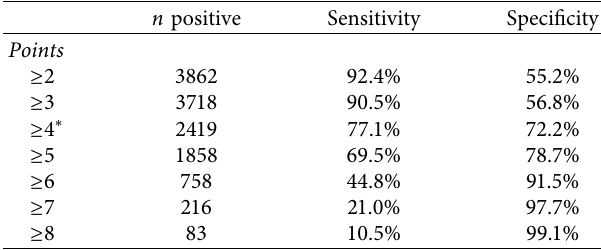
Table 3: Classification statistics for cut points in the TBSE model.